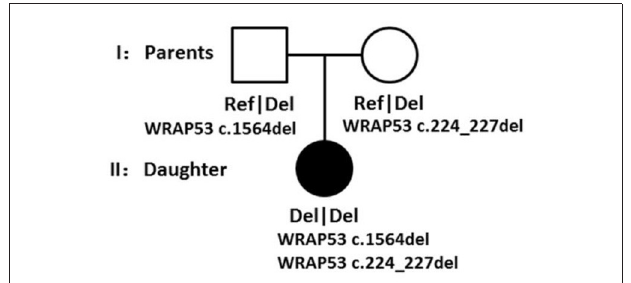
FIGURE 9 | Family pedigree showing the genotypes segregating with the phenotype.